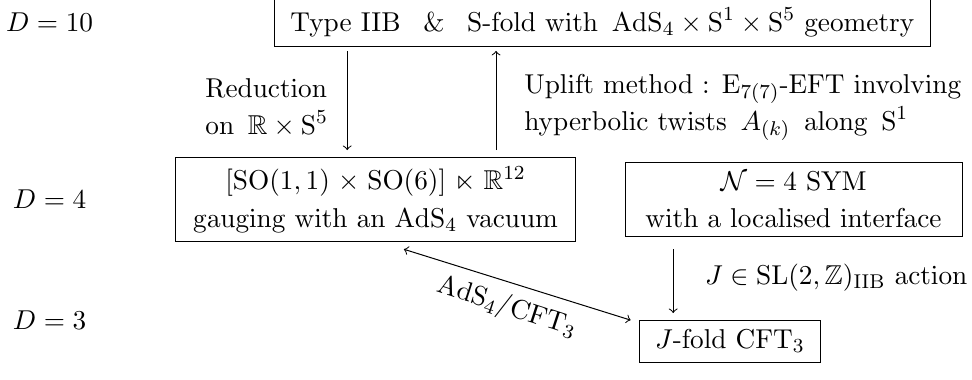
Figure 1 . Type IIB S-folds with hyperbolic monodromies M ( k ) = (cid:0)ST k along S 1 and connection with three-dimensional J -fold